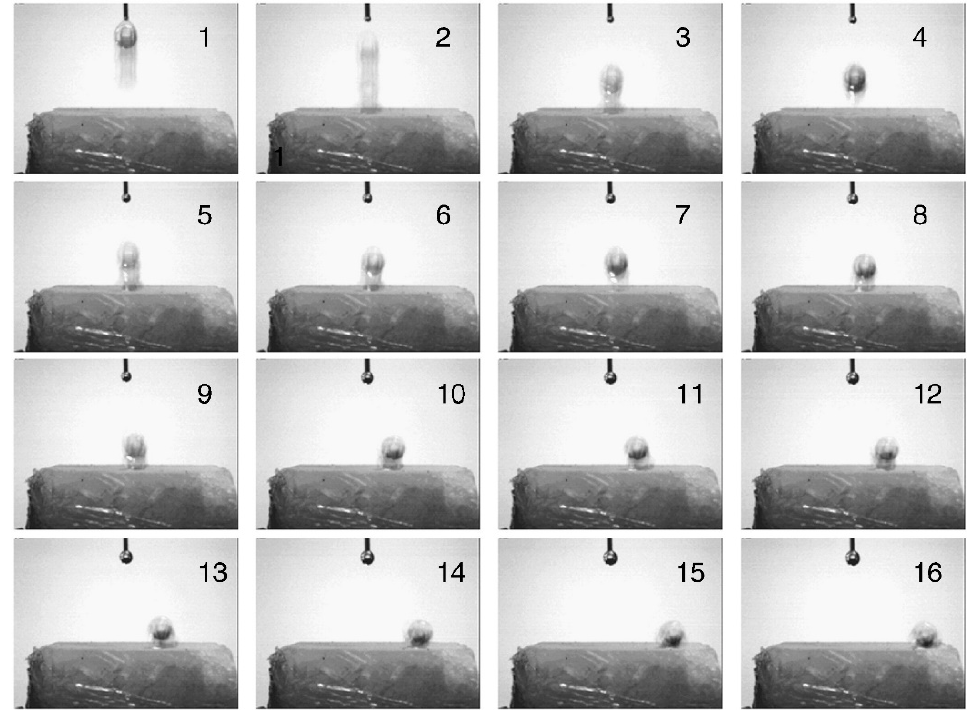
Figure 10. Consecutive images of a water droplet bouncing and rolling off a Pentelic marble treated with siloxane and 1.5% w / v silica nano-particles. Reprinted with permission from [52]. Copyright 2009 Elsevier.